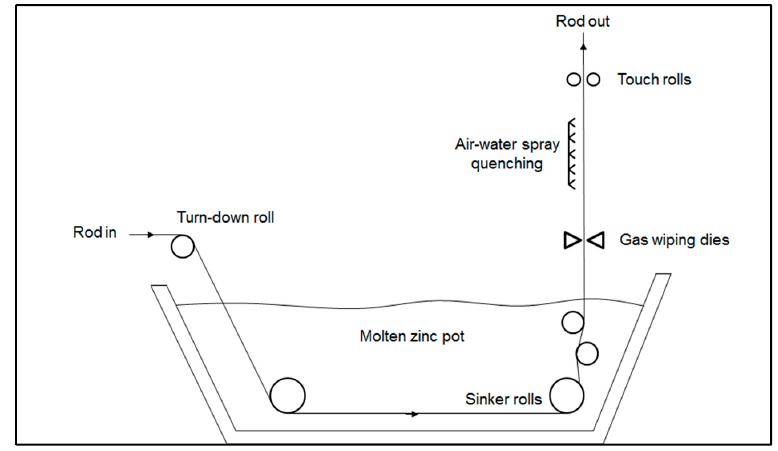
Figure 1. Schematic sketch of a continuous galvanizing process for wires and rods.